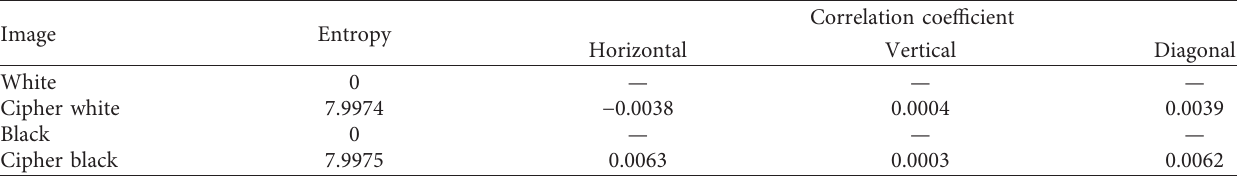
Figure 16: Test for resistance against plaintext attacks using all-white and all-black images. (a) White image, (b) cipher image of white, (c) the histogram of (b), (d) black image, (e) cipher image of black, and (f) the histogram of (e). Table 11: Entropies and correlation coefficients of plaintext